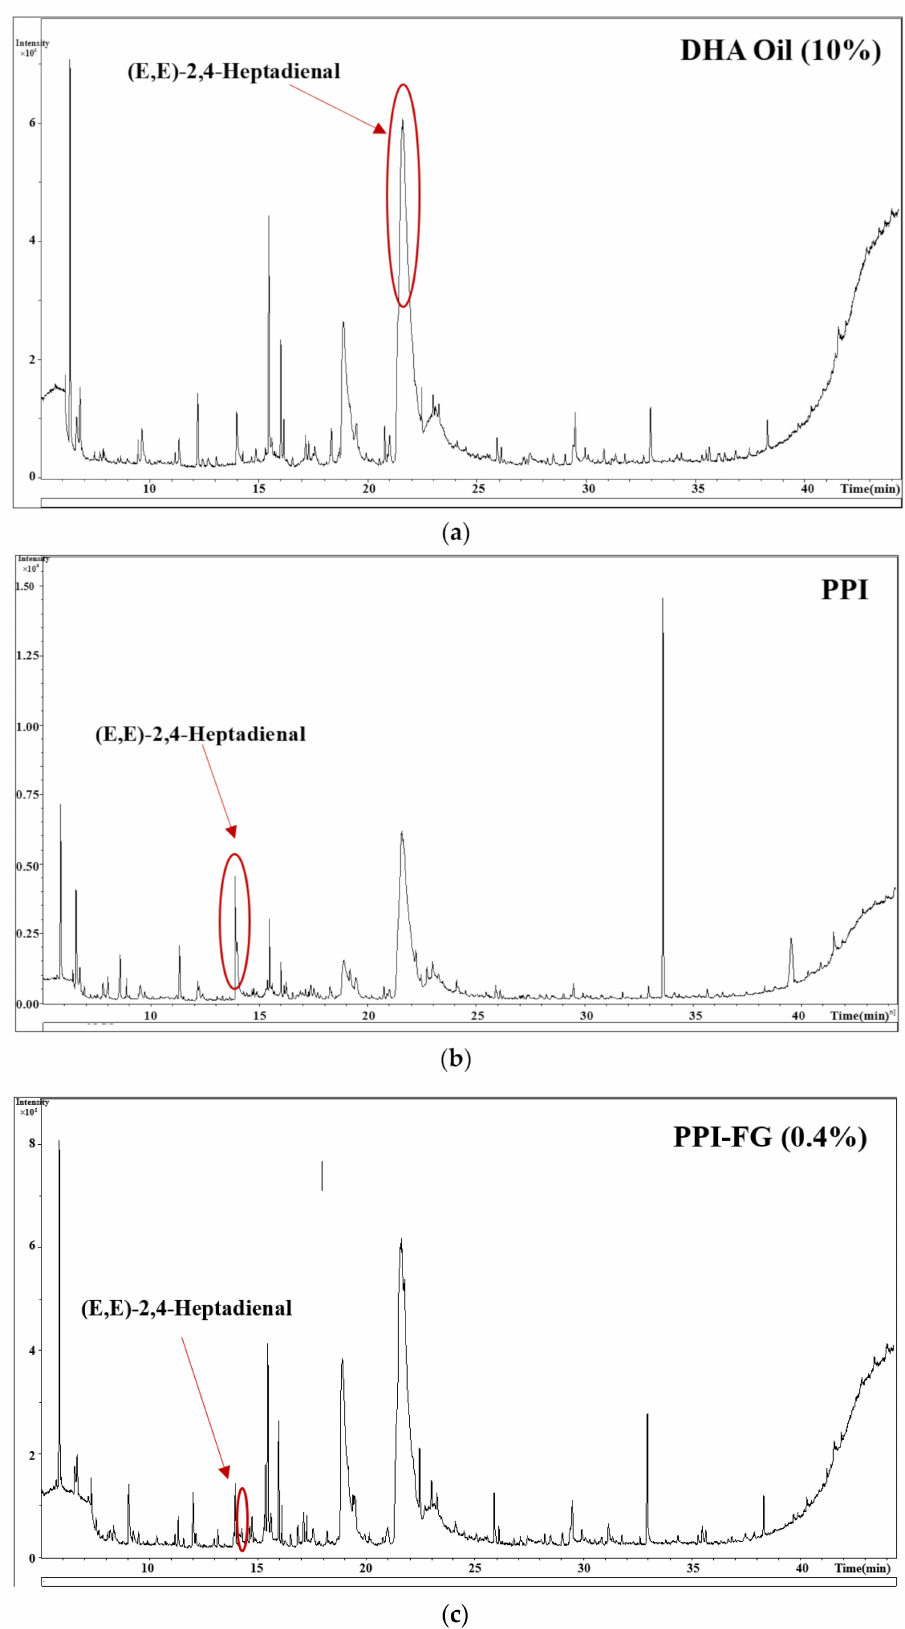
Figure 4. Algal oil emulsion volatile substance gas chromatogram: ( a ) algae oil, ( b ) PPI emulsion, ( c ) PPI–FG (0.4%)